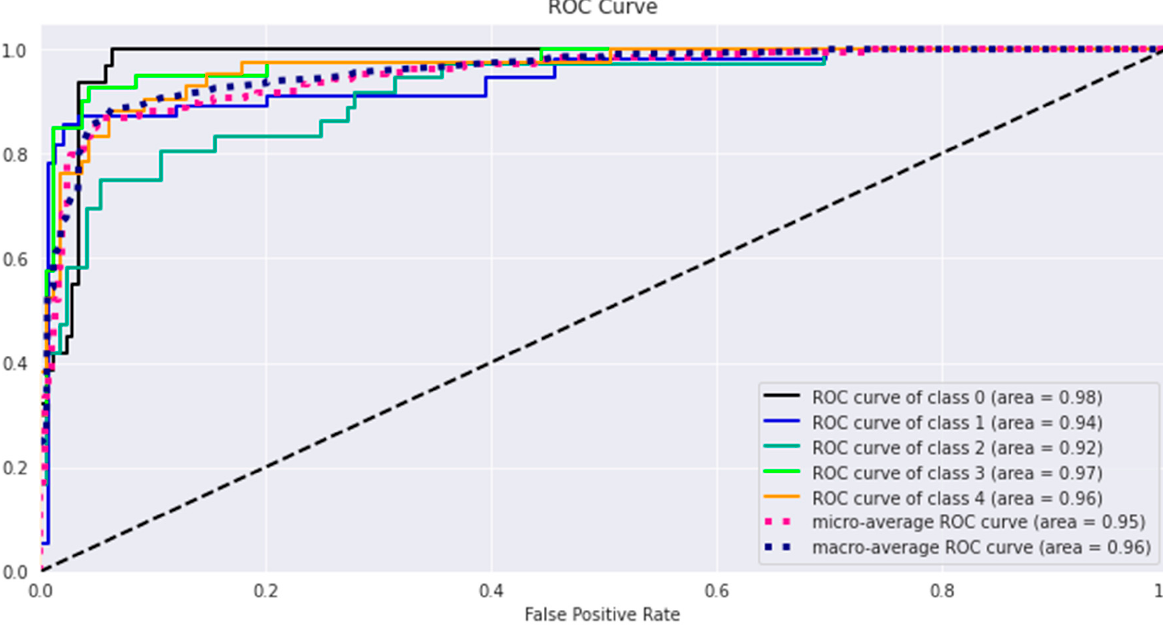
Figure 11. Region of convergence of random configuration.